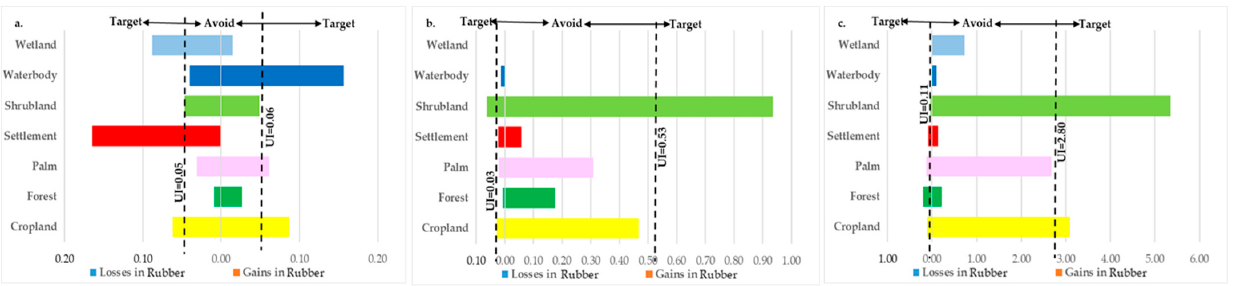
Figure 8. Transition level intensities for settlement for the period ( a ) 1986–2002, ( b ) 2002–2015 and ( c ) 2015–2020 (gains on the right, losses on the left). Figure 9. Transition level intensities for cropland for the period ( a ) 1986–2002, ( b ) 2002–2015 and ( c ) 2015–2020 (gains on the right, losses on the left). Figure 10. Transition level intensities for palm for the period ( a ) 1986–2002, ( b ) 2002–2015 and ( c ) 2015–2020 (gains on the right, losses on the left).